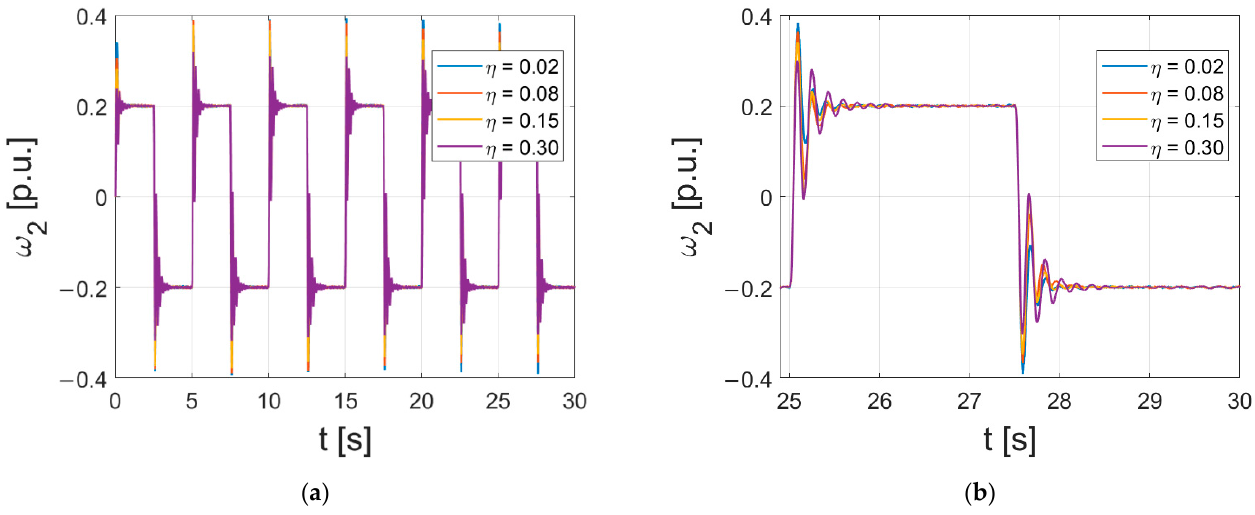
Figure 13. The impact of a different value of the learning coefficient: ( a ) a general overview of the experimental run; ( b ) a zoom-in at the final reversions of the experimental run.